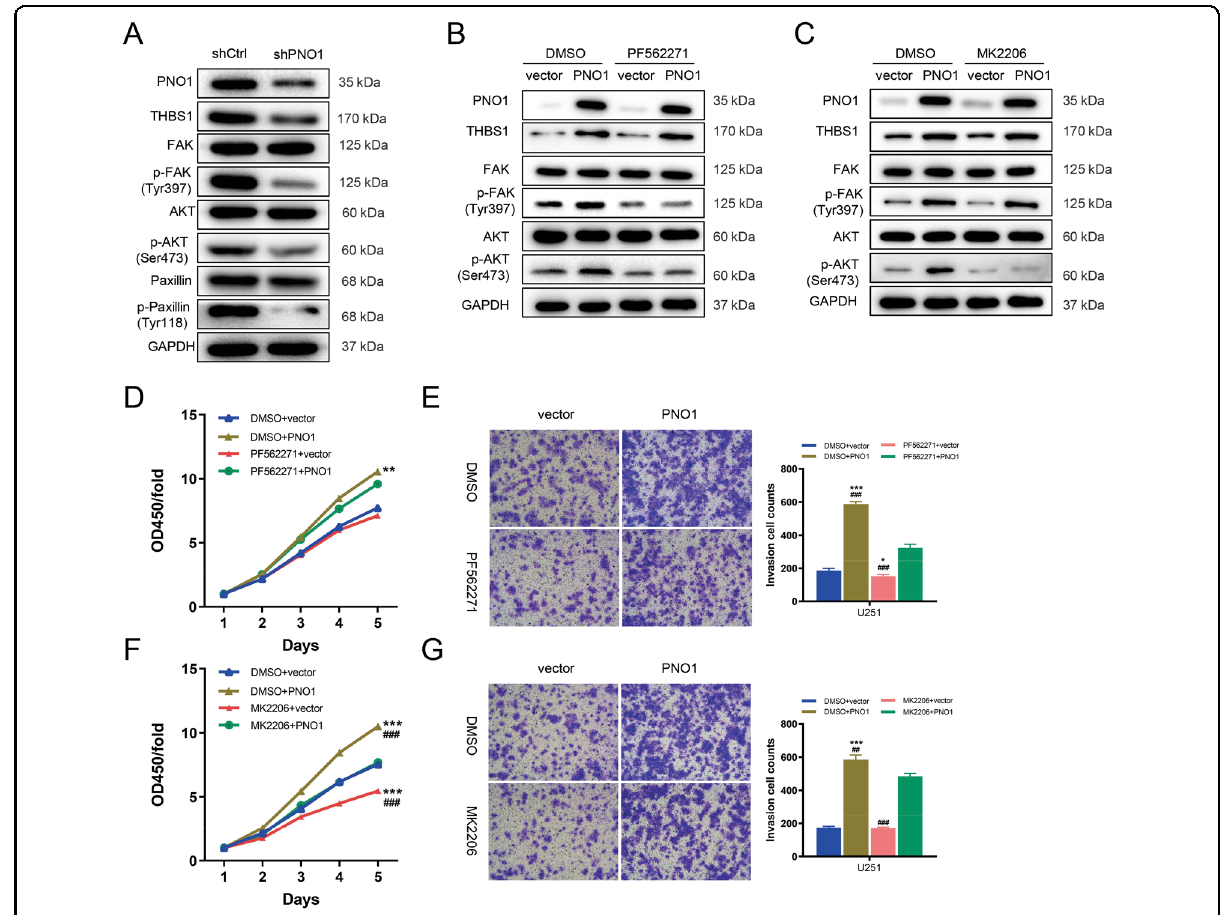
Fig. 6 PNO1 activates FAK-Akt signaling through THBS1. A Western blotting showing the protein expression levels in U251 cell lines infected with shPNO1 or shCtrl (vector). B Western blotting showing the protein expression levels in U251 cells infected with PNO1 overexpression or the control (vector), and treatment with or without PF562271 (FAK inhibitor). C Western blotting showing the protein expression levels in U251 cells infected with PNO1 overexpression or the control (vector), and treatment with or without MK2206 (Akt inhibitor). D CCK8 assay showing cell growth in U251 cells infected with PNO1 overexpression or the control (vector), and treatment with or without PF562271 (FAK inhibitor). E Transwell assay showing cell invasion in U251 cells infected with PNO1 overexpression or the control (vector), and treatment with or without PF562271 (FAK inhibitor). F CCK8 assay showing cell growth in U251 cells infected with PNO1 overexpression or the control (vector), and treatment with or without MK2206 (Akt inhibitor). G Transwell assay showing cell invasion in U251 cells infected with PNO1 overexpression or the control (vector), and treatment with or without MK2206 (Akt